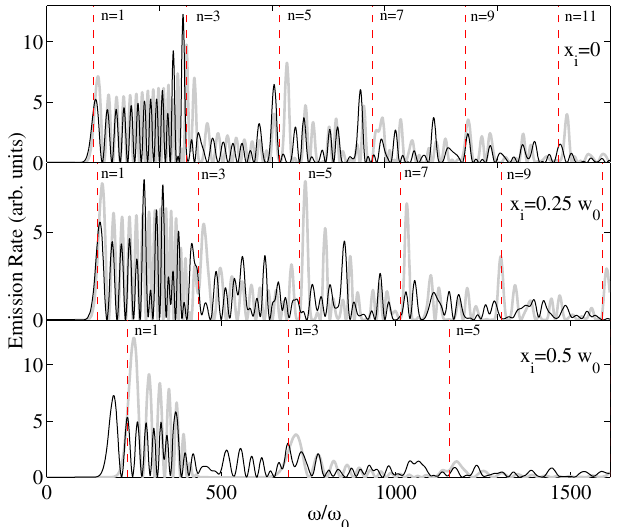
FIG. 6. Thomson emission spectra for electrons with varying impact parameters x . The laser is of peak intensity a 0 ¼ 2 , i λ ¼ 0 . 8 μ m, and with a Gaussian profile of 27 fs duration. The incoming electrons have an initial γ 0 ¼ 10 and are counter- propagating with the laser pulse. Their impact parameters are listed in the figure panels. Black lines: emission spectra calcu- lated for a paraxial laser pulse focussed to θ 0 ¼ 1 = π , ( w 0 ¼ λ ). Gray (thick) lines: emission spectra calculated using a plane wave laser, with peak amplitude reduced to compensate for the fall-off in the focussed field (see main text for details). Red (dashed) lines: the positions of the harmonics in the case of a monochromatic field, calculated using the same a 0 as the plane wave spectra.